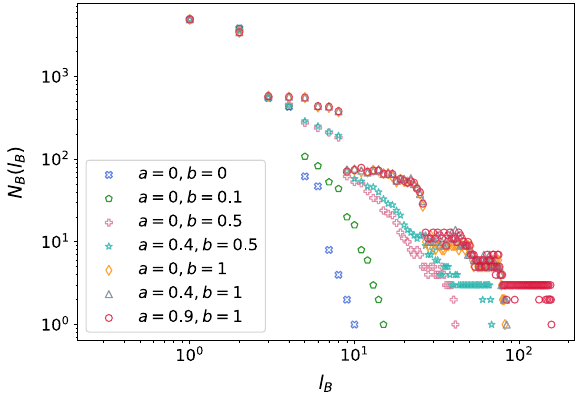
Fig. 5 Illustration of the fractality of the Hub attraction dynamical growth model for different parameter settings. The iteration number is fixed to 4, parameter m to 3, and T =